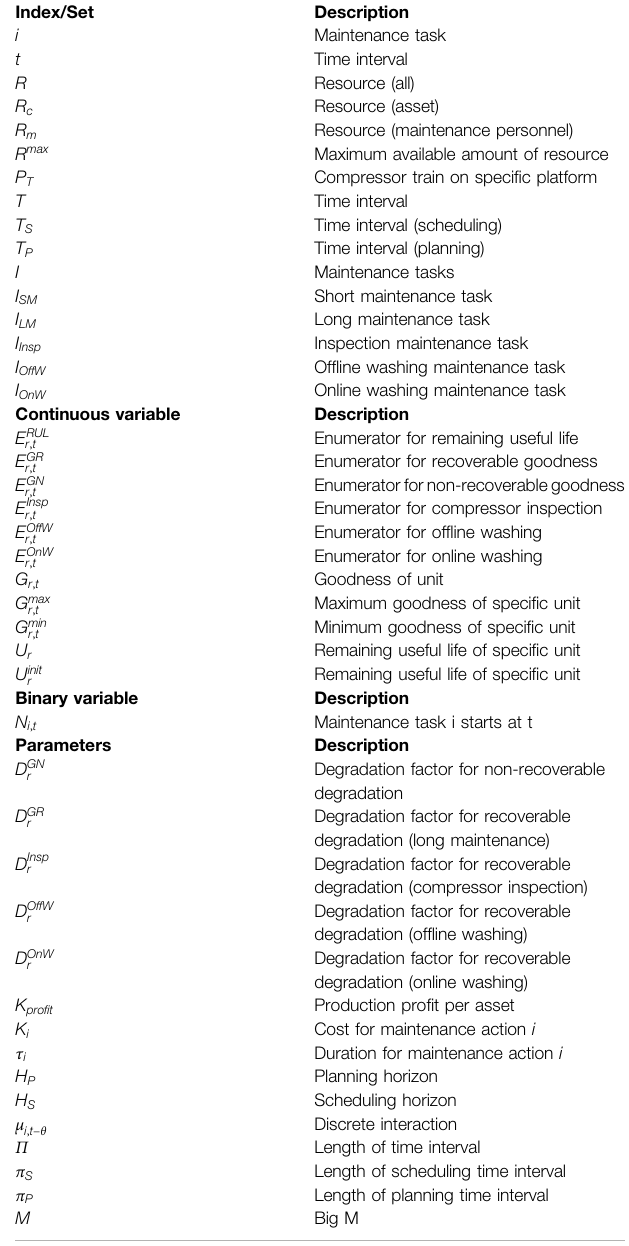
TABLE 3 | Notation for the planning and scheduling